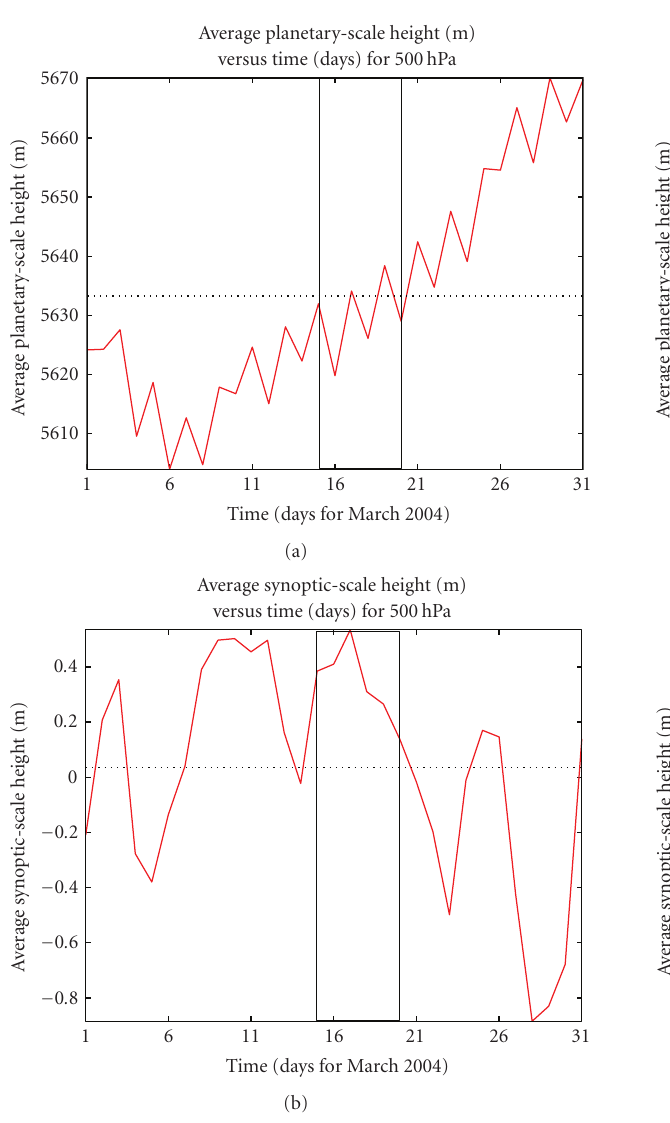
Figure 1: (a) The blocking area averaged planetary-scale 500 hPa height (m) versus time (days), for a stationary box (20 ◦ N to 60 ◦ N and 330 ◦ E to 30 ◦ E), in the midlatitude northern hemispheric flow. The dashed dotted horizontal line defines the monthly mean value for the planetary-scale height. The left vertical line marks the beginning, whereas the right vertical line marks the end of the selected blocking event; (b) same as Figure 1(a) except for the synoptic-scale height.